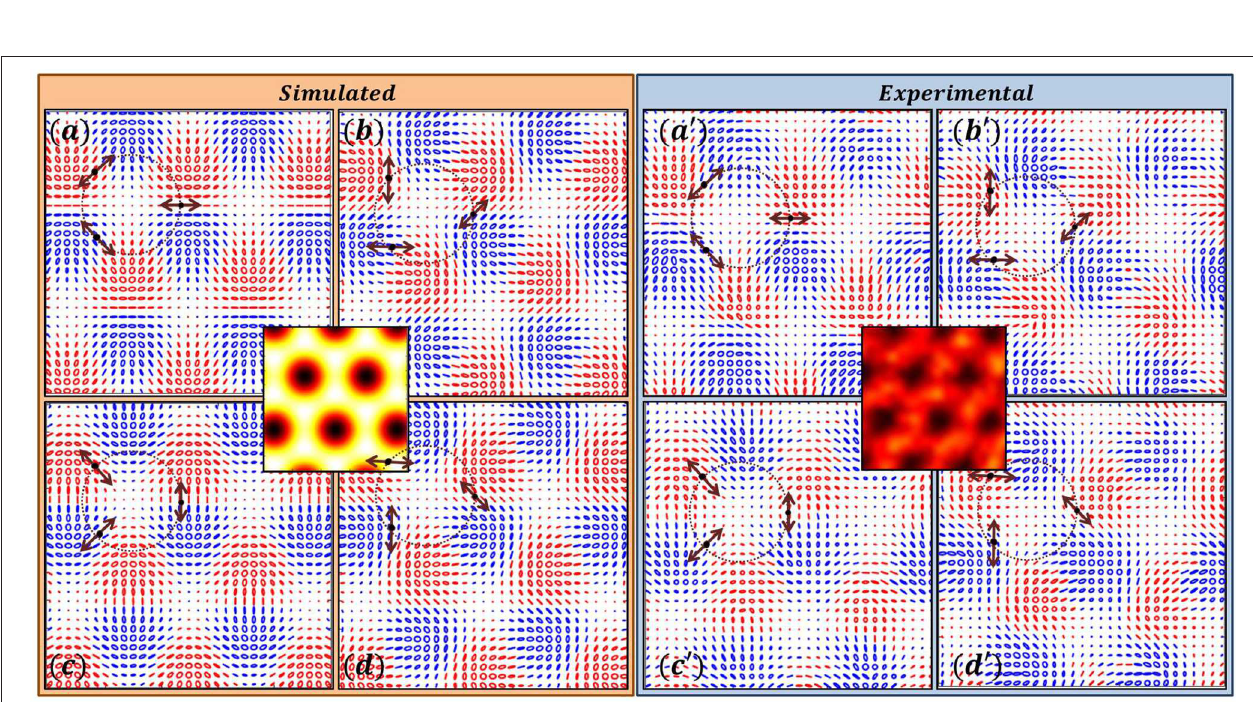
Frontiers in Physics | www.frontiersin.org